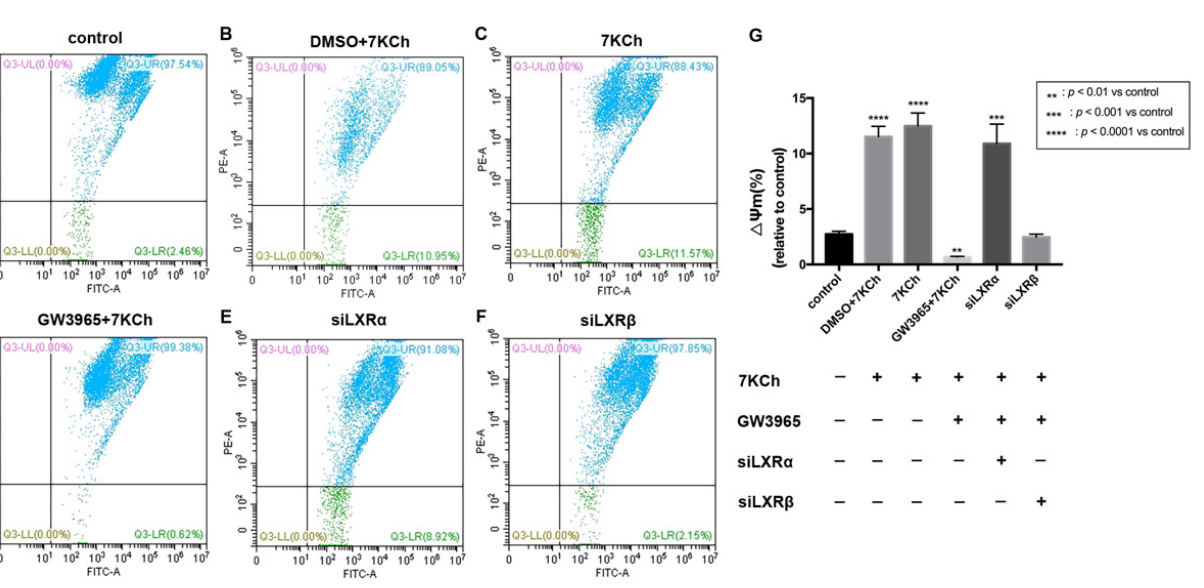
Figure 8. Flow cytometric analysis of mitochondrial membrane potential in ARPE-19 cells. ( A ) As a control, ARPE-19 cells were cultured with a serum-free medium for 48 h. ( B ) ARPE-19 cells were incubated with DMSO (0.02%) for 24 h, followed by 7KCh (20 µ M) for 24 h. ( C ) ARPE-19 cells were cultured with serum-free medium for 24 h and then incubated with 7KCh (20 µ M) for 24 h. ( D ) ARPE-19 cells were incubated with GW3965 (2 µ M) for 24 h, followed by 7KCh (20 µ M) for 24 h. ( E ) ARPE-19 cells were first transfected with siLXR α as previously described and then incubated with 7KCh (20 µ M) and GW3965 (2 µ M) for 24 h. ( F ) ARPE-19 cells were first transfected with siLXR β as previously described and then incubated with 7KCh (20 µ M) and GW3965 (2 µ M) for 24 h. After treatment, the cells were collected and subjected to flow cytometric analysis of mitochondrial membrane potential. ( G ) Mitochondrial membrane potential was quantified. Data are represented as mean ± SEM of three independent experiments. Differences of p < 0.05 were considered statistically